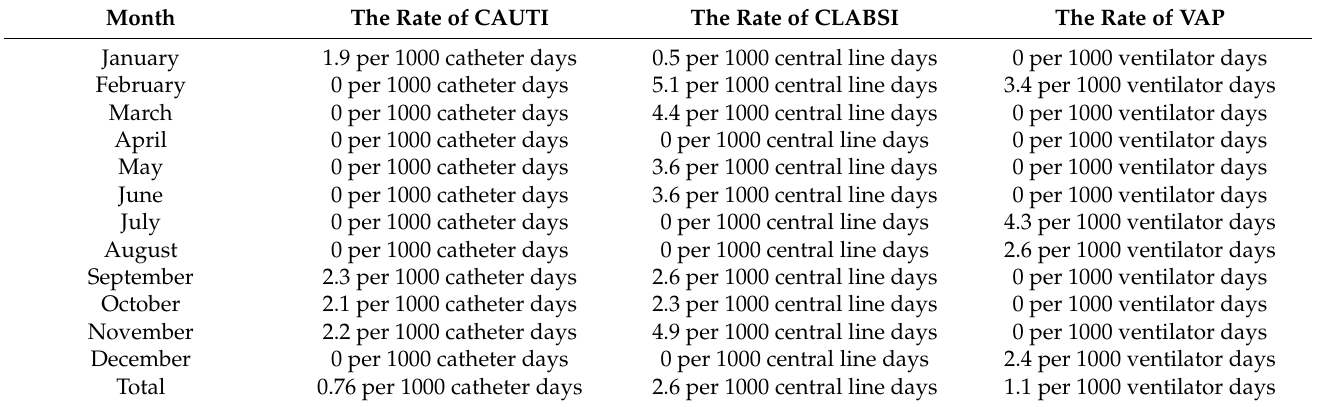
Table 2. The rate of CAUTI, CLABSI, and VAP.